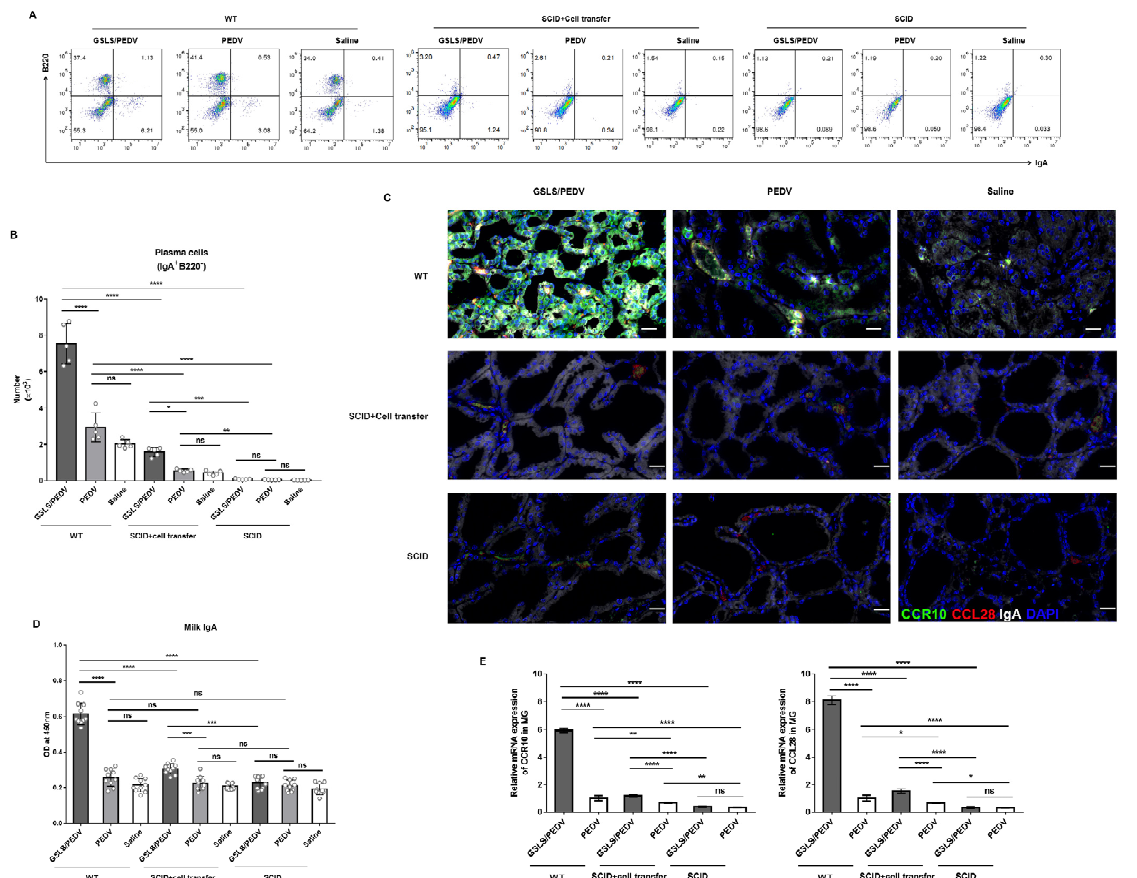
Figure 6. Immunode fi cient mice transplanted with PP cells re-establish the intestinal microbiota and regain intestinal immunity after GSLS treatment. Female wild-type (C.B-17/ICR-+/+Jcl, WT) and im- munode fi cient (C.B-17/ICR-scid/scidJcl, SCID) mice were gavaged daily with GSLS or saline for 2 weeks. Some SCID mice received PP cell transplantation 1 day after the fi rst gavage. All mice (n = 5/group) were vaccinated and mated in the same way as described in Figure 1 and were sacri fi ced on day 7 after parturition. ( A ) Experiment scheme. ( B ) PCoA of the intestinal micro fl ora genera based on weighted UniFrac distances. ( C ) Relative abundance bar chart of intestinal fl ora constitu- ents at the genus level. ( D ) Frequencies of Lactobacillus , Ligilactobacillus and Odoribacter in the intes- tinal micro fl ora. ( E , F ) Representative haematoxylin-eosin staining images of intestinal intraepithelial lymphocytes (iIELs) (indicated as arrows) in the SI and quantitative analysis. Scale bar = 50 µm. ( G ) Representative images of immunofluorescence-labelled IgA (white) and CCR10 (red) in the SI. Scale bar = 50 µ m. ( H ) The production of PEDV-specific intestinal IgA. ( I ) The mRNA expression of CCR10 in the SI. Data are presented as the means ± SDs and were analysed by one-way ANOVA with Tukey’s multiple comparisons. Abbreviations: WT, wide-type; SCID, severe combined immunodeficiency; OD, optical density; PP, Peyer’s patch. * p < 0.05, ** p < 0.01, **** p < 0.0001. ns, no significant difference.